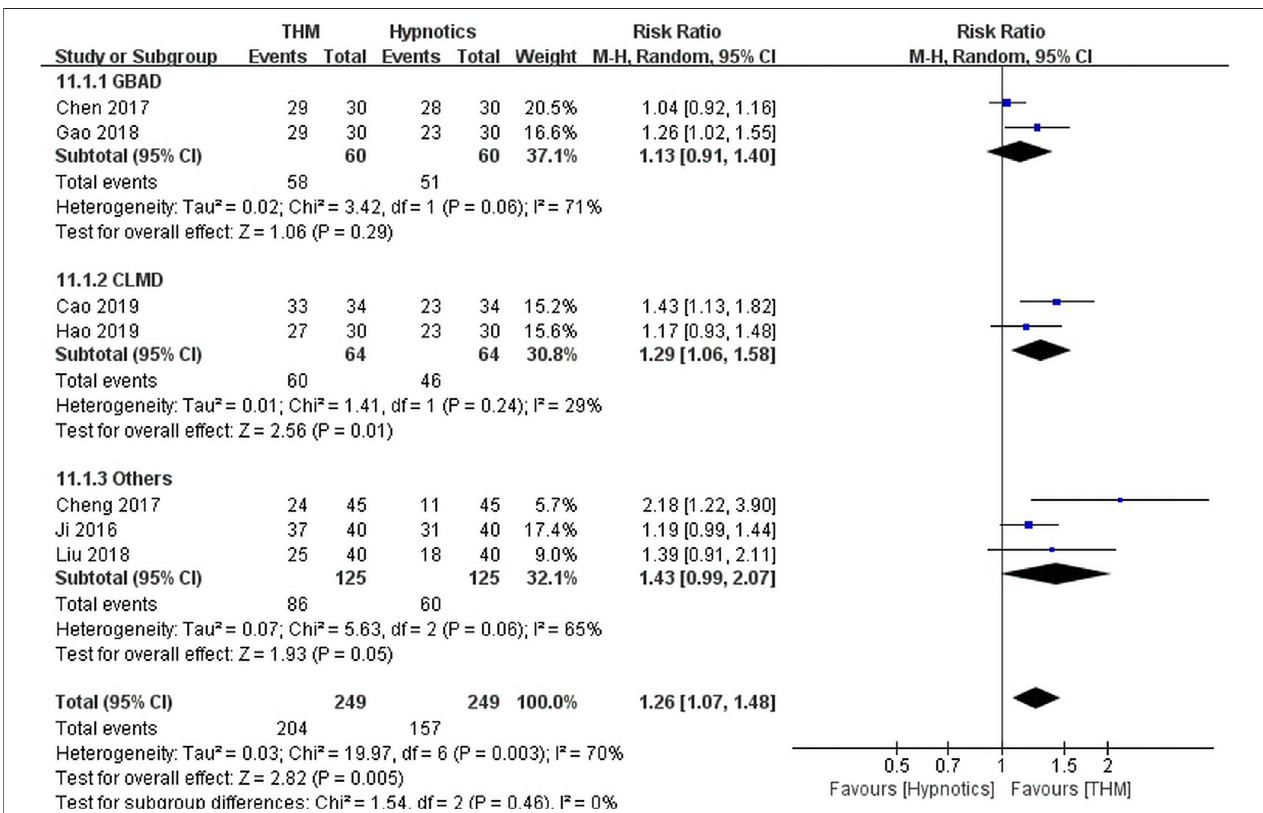
FIGURE4| ForestplotoftotaleffectiverateforTHMversushypnotics.THM,traditionalherbalmedicine;GBAD,GubenAnshen decoction;CLMD,ChaihuLonggu Muli decoction.